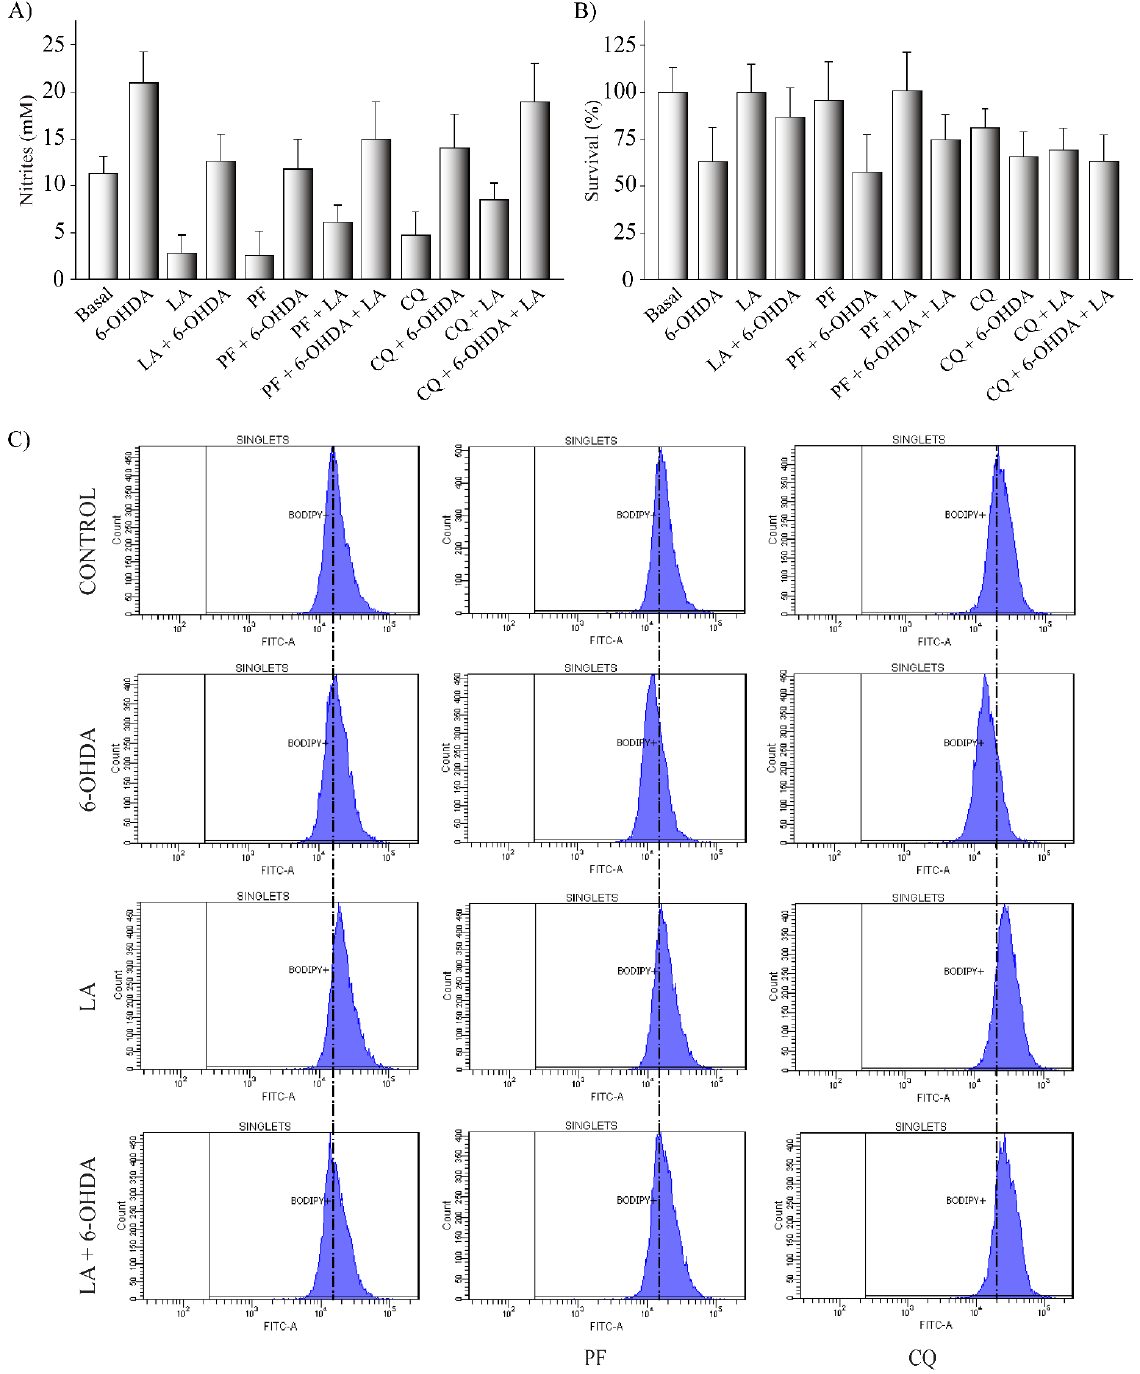
Figure A3. ( A , B ) The human cell line SH-SY5Y was exposed to 35 µ M 6-OHDA in the presence or not of LA, PF, and CQ. The cell viability was measured by MTT assay and determination of nitrites concentration was evaluated by Griess reaction. Each bar represents the mean ± SD of three independent experiments with 6 replications each per experimental group. ( C ) BODIPY 493/503 flow cytometry experiments on SH-SY5Y PD model. Representative histograms of flow cytometry experiments with the SH-SY5Y cells marked with BODIPY 493/503 (FITC-A signal) and treated or not with LA, 6-OHDA, PF, and/or CQ. The results correspond to 6 independent experiments per